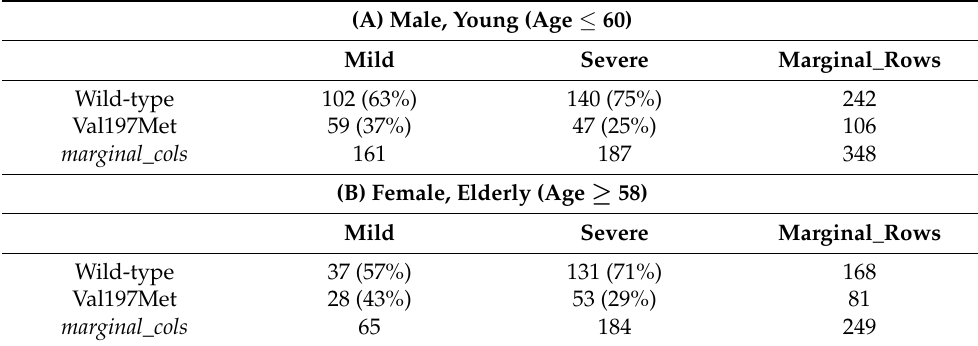
Table 2. Contingency tables of V197M TMPRSS2 in young males and elderly women.